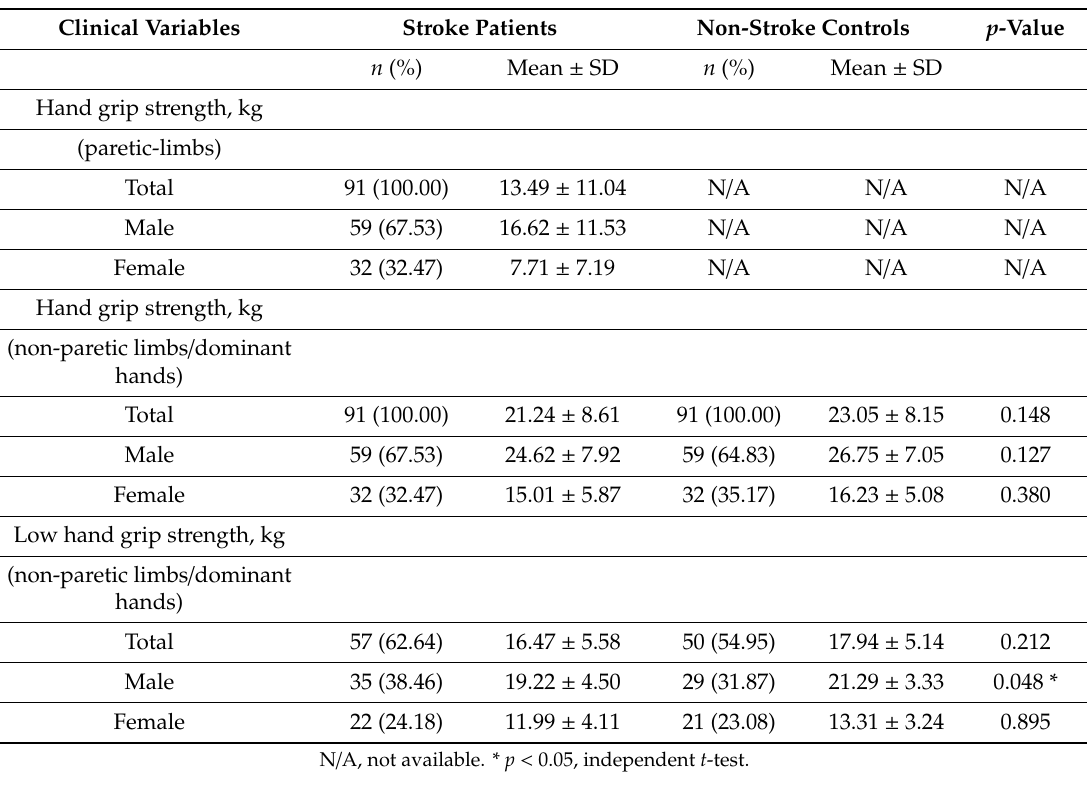
Table 2. Hand grip strength of paretic and non-paretic limbs in stroke patients and dominant hands in non-stroke